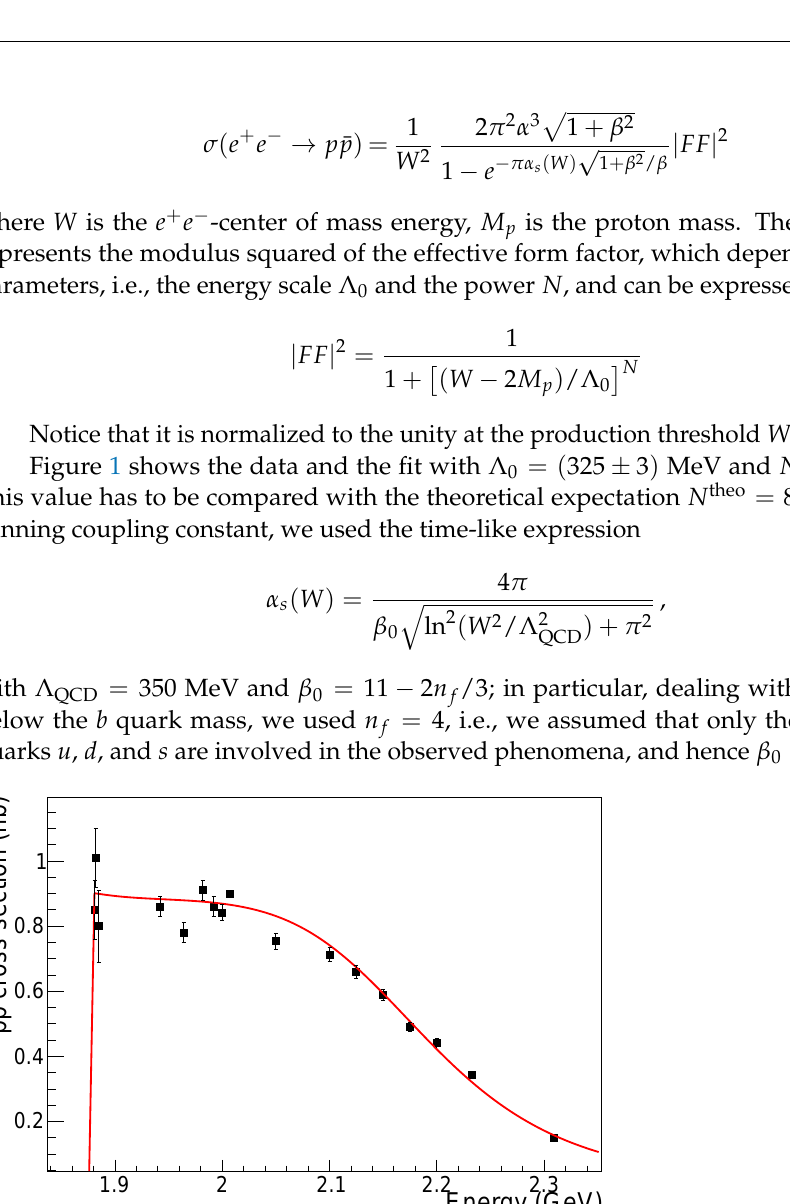
Figure 1. Fit to the most recent BESIII and CMD3 data with the strong corrected Coulomb enhance- ment factor (CEF). The red line shows the cross section values as fitted from Equation (6), whereas the black dots with error bars indicate the experimental measured